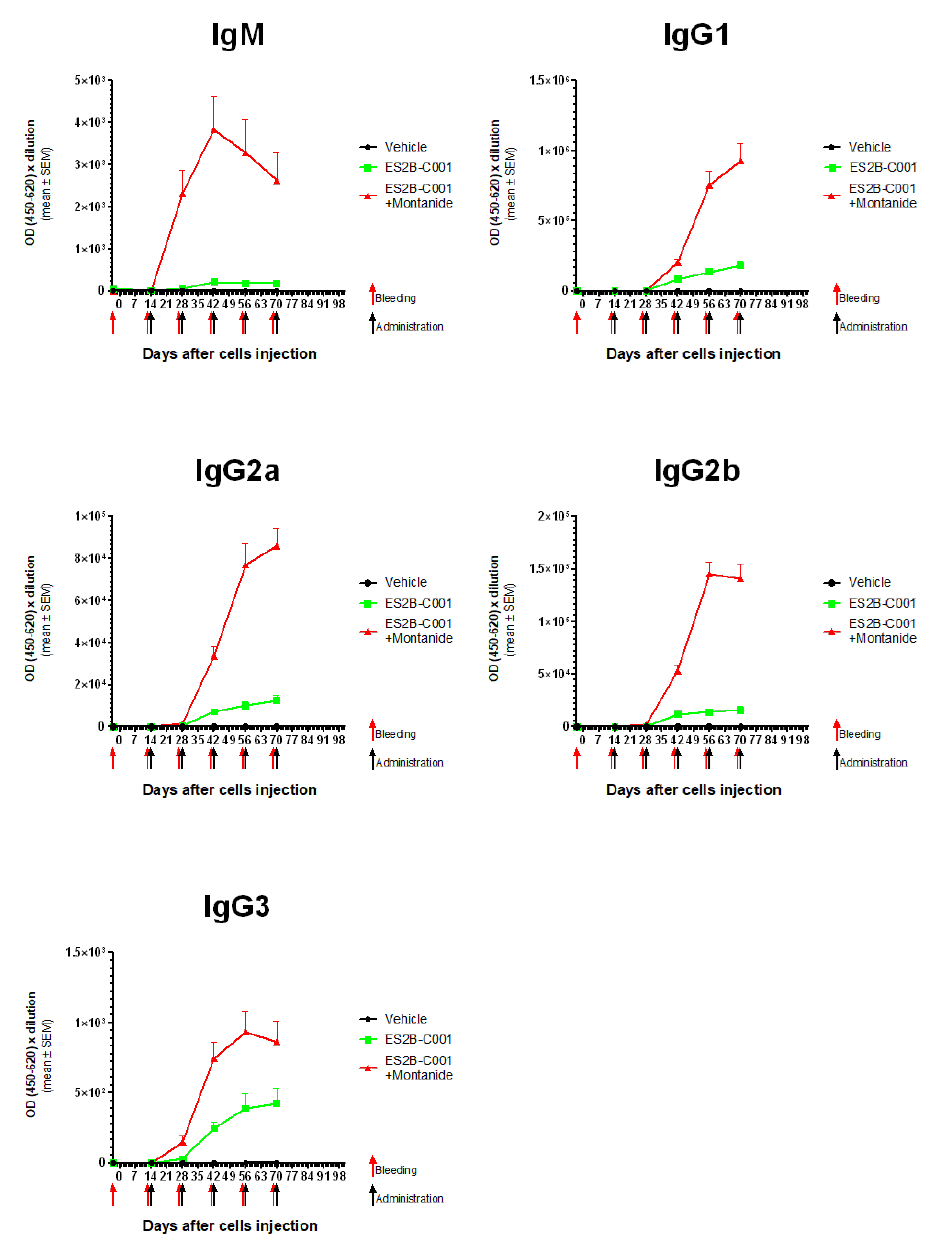
Figure 4. HER-2 specific IgM and IgG isotypes elicited by ES2B-C001 therapeutic vaccinations. Each point represents the mean (and SEM) of mouse groups shown in Figures 1 and